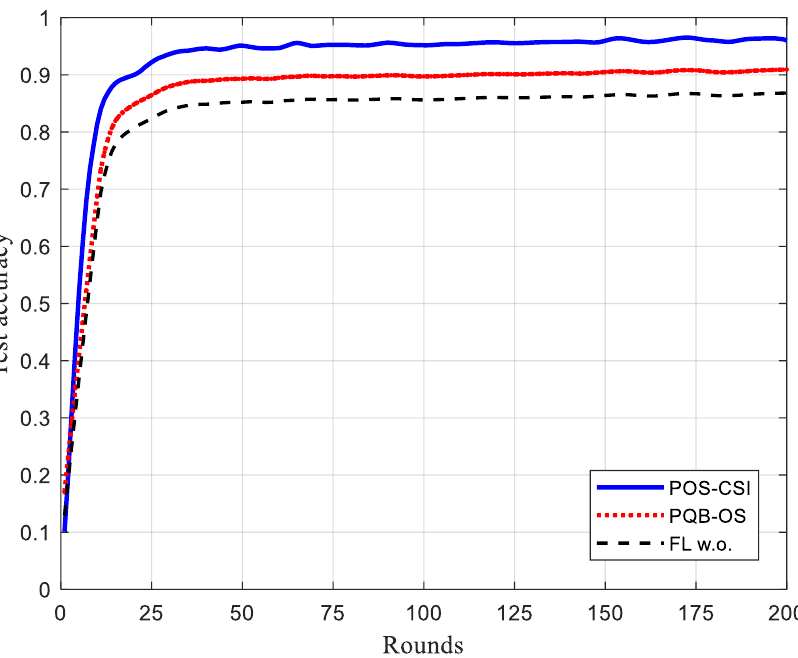
Figure 4. Test accuracy of proposed scheme and two benchmark schemes for MNIST dataset under non-IID distribution, when ∆ T = 50 s, B n = 1 MHz, P n = 0.5 W, and D n = 200.